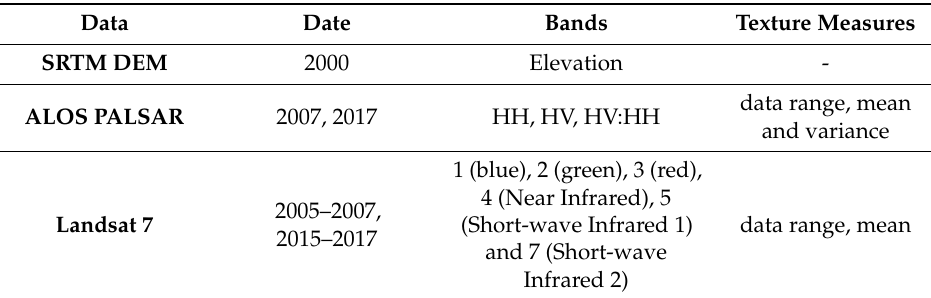
Table 2. Earth Observation (EO) data used for